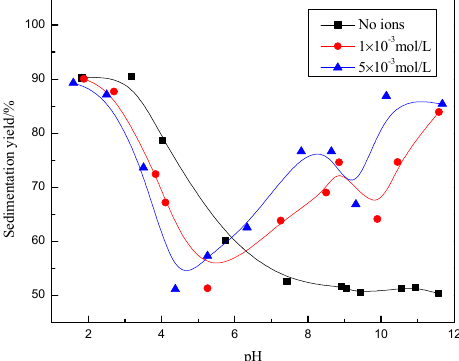
Figure 3. Effect of pH value on dispersion and flocculation of mineral with the presence of Mg 2+ .